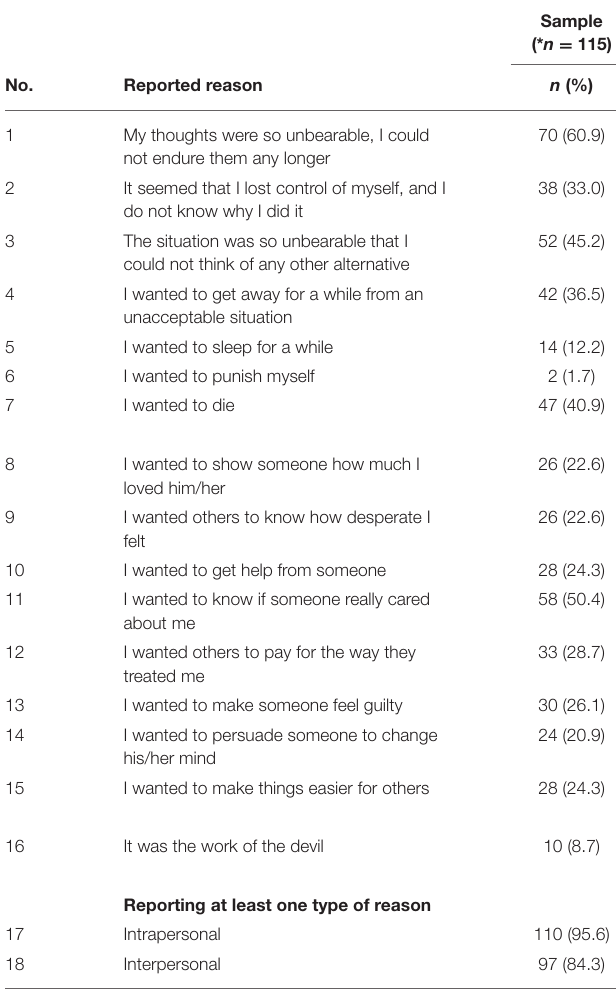
TABLE 3 | Reported reasons/motivations for last episode of self-harm behaviour.